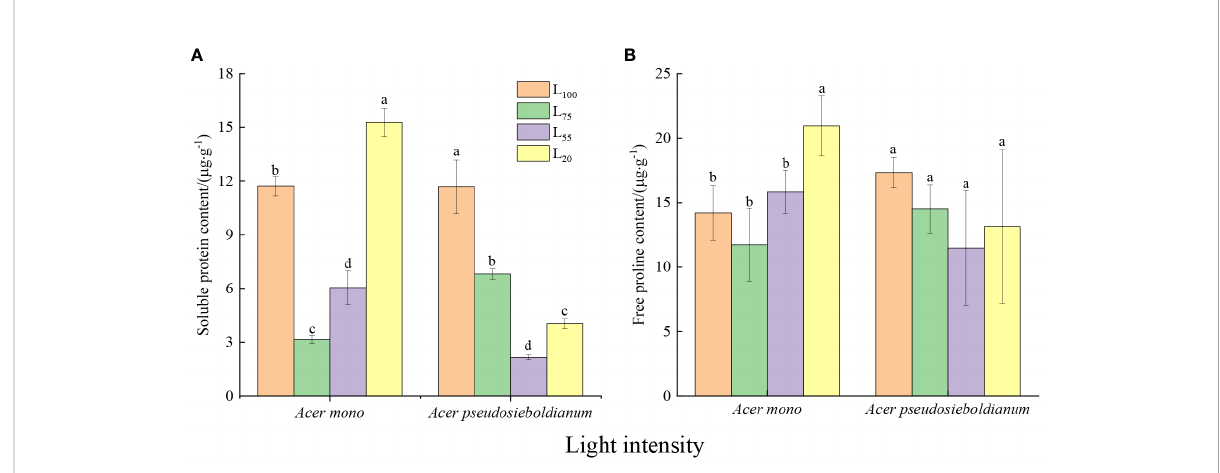
FIGURE 3 Effect of light intensity on osmoregulation substance ( A , soluble protein; B , free proline contents). Small letters indicate signi fi cant differences under different light intensities ( P <